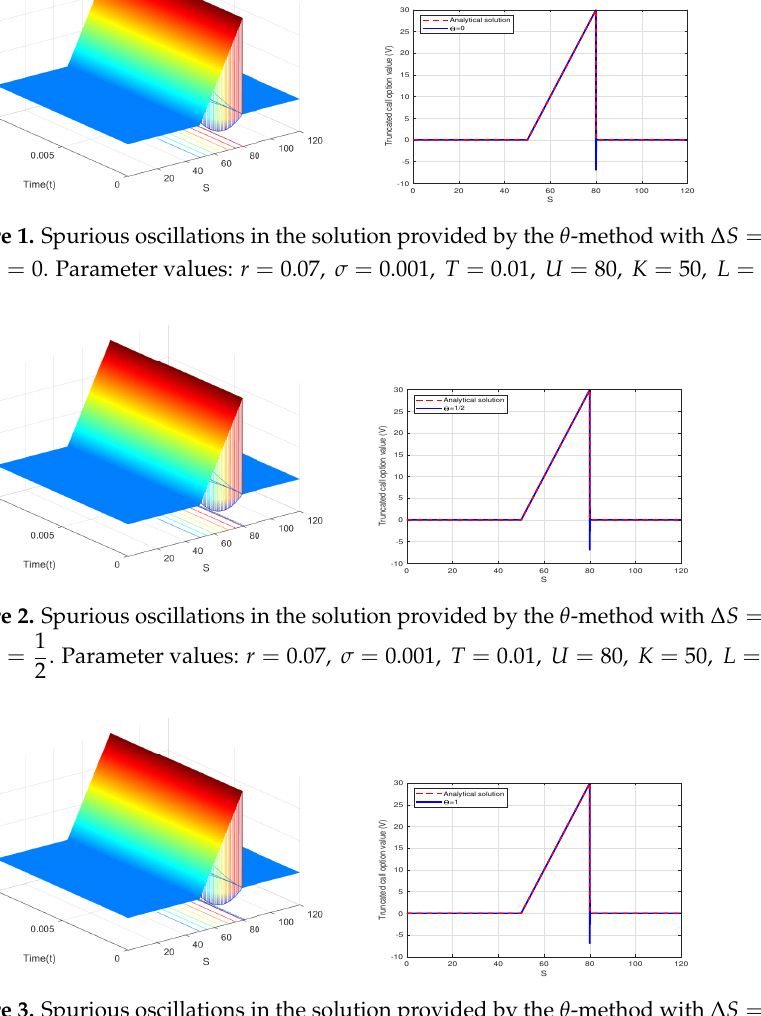
Figure 3. Spurious oscillations in the solution provided by the θ -method with ∆ S = 0.01, ∆ t = 10 − 4 , and θ = 1. Parameter values: r = 0.07, σ = 0.001, T = 0.01, U = 80, K = 50, L = 20, S max = 120.